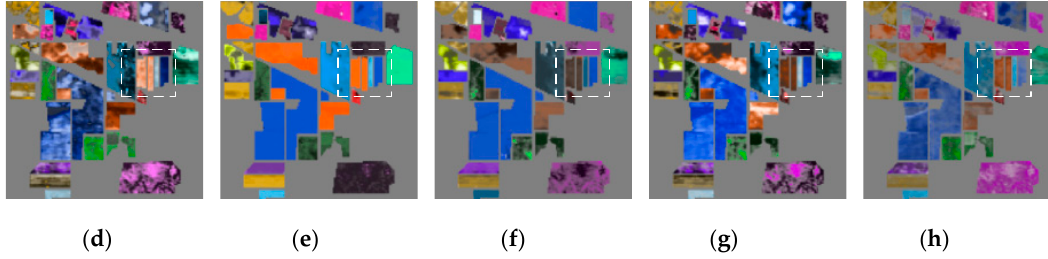
Figure 5. Visualization result for Indian Pines. ( a ) Principal component analysis (PCA); ( b ) color matching function (CMF); ( c ) band selection; ( d ) t-distributed stochastic neighbor embedding (T-SNE); ( e ) local tangent space alignment (LTSA); ( f ) locally linear embedding (LLE); ( g ) Laplacian eigenmaps (LE); ( h ) isometric feature mapping (ISOMAP).